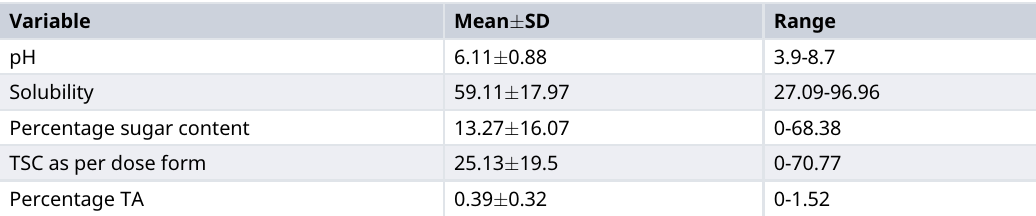
Table 2. Descriptive statistics of overall potential of Hydrogen (pH), solubility, percentage sugar content, total sugar content (TSC) as per dose form, and percentage titratable acidity (TA) among the Orodispersible